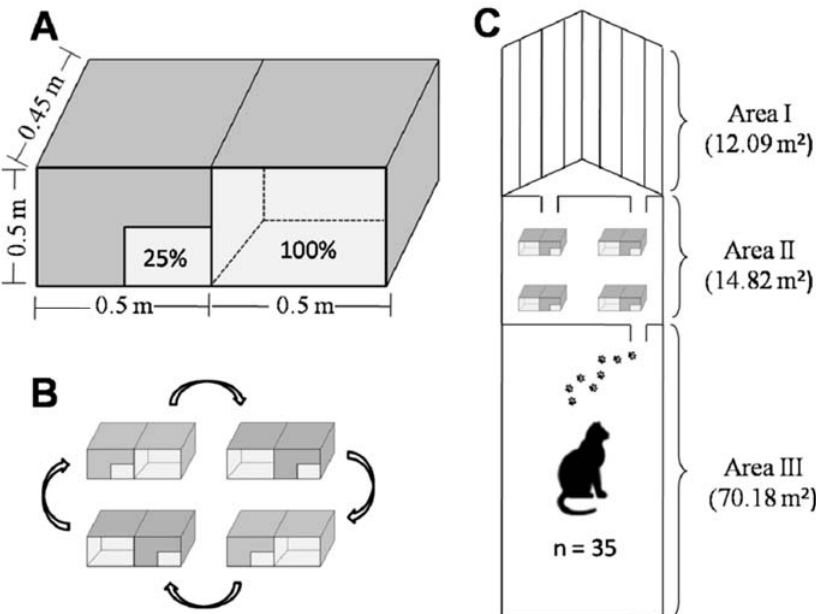
Figure 1. ( A ) Representation of pairs of cardboard refuges used in Experiment I; ( B ) Diagram with arrows that indicate the rotation applied to each day of Experiment I; ( C ) Sketch of total area available for cats observed in this study.